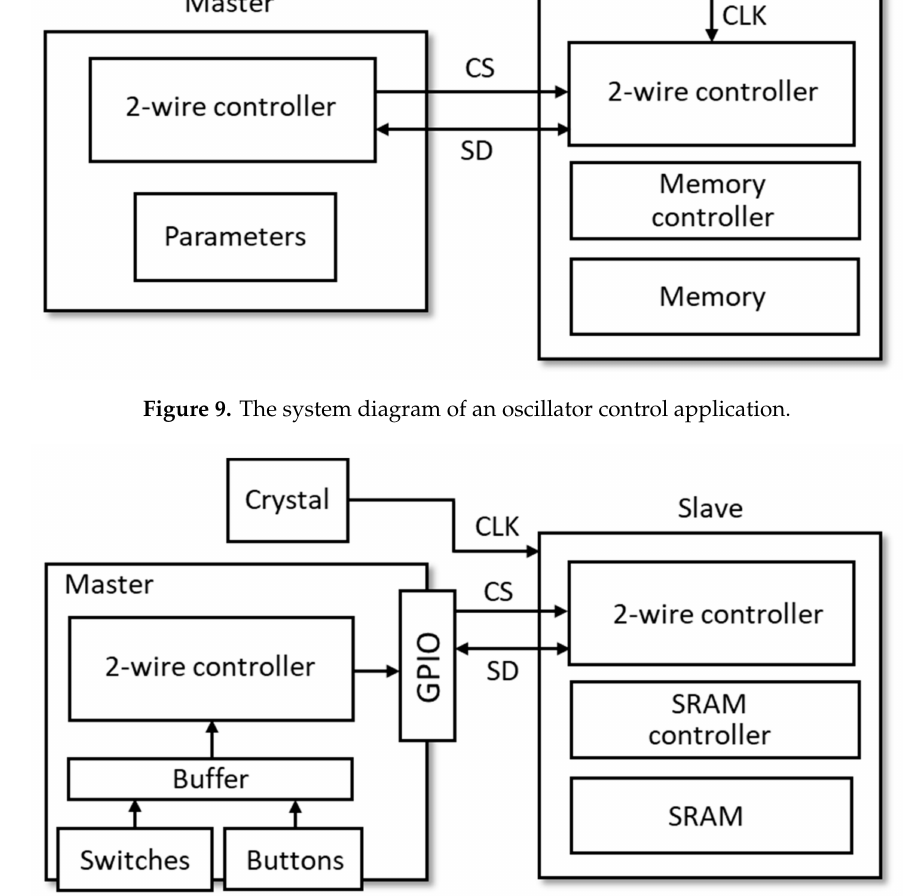
Figure 10. Interconnection of the master device and the slave